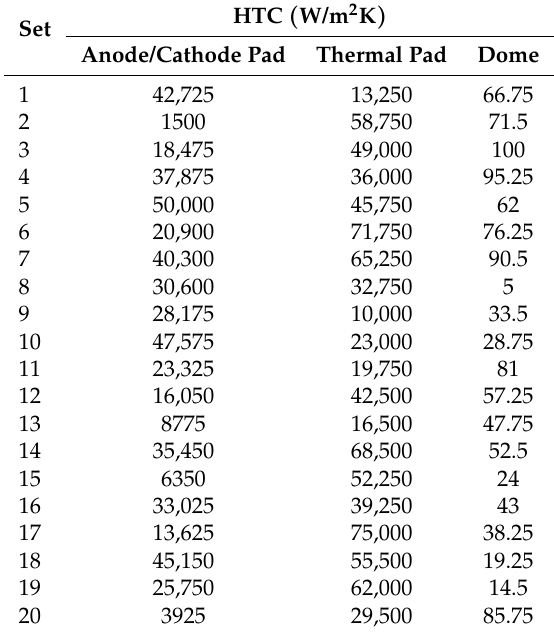
Table 2. HTC testing sets used to generate test data for the LED CTM